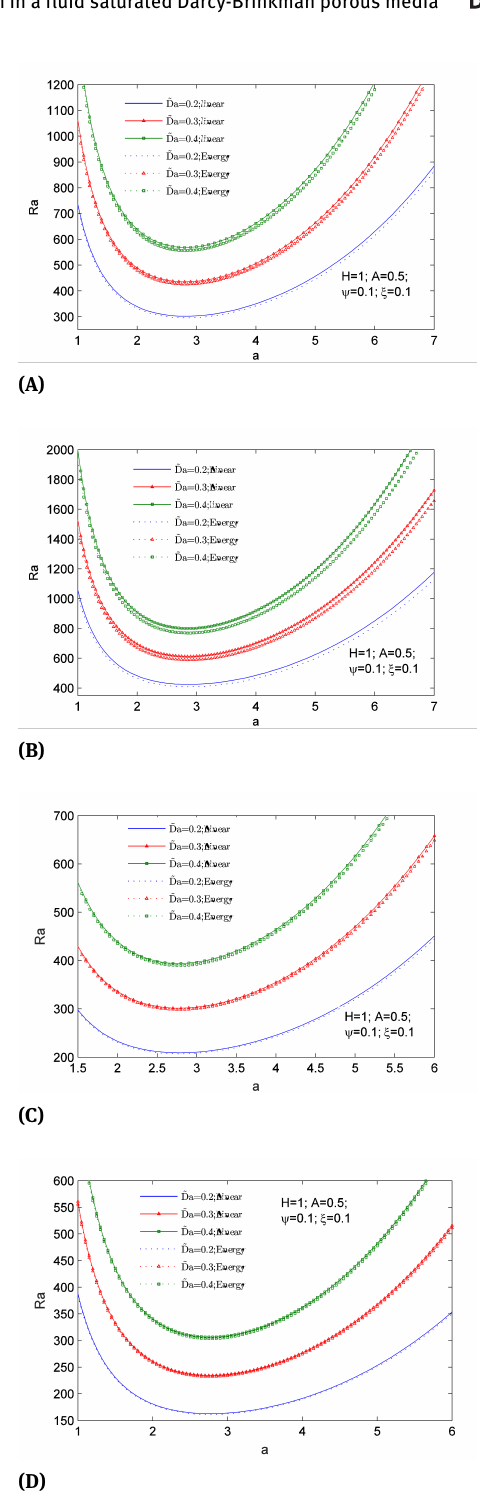
Fig. 3: Neutral stability curves for case A, B, C and D at different values of ˜ Da and fixed values of H , ξ , ψ ,